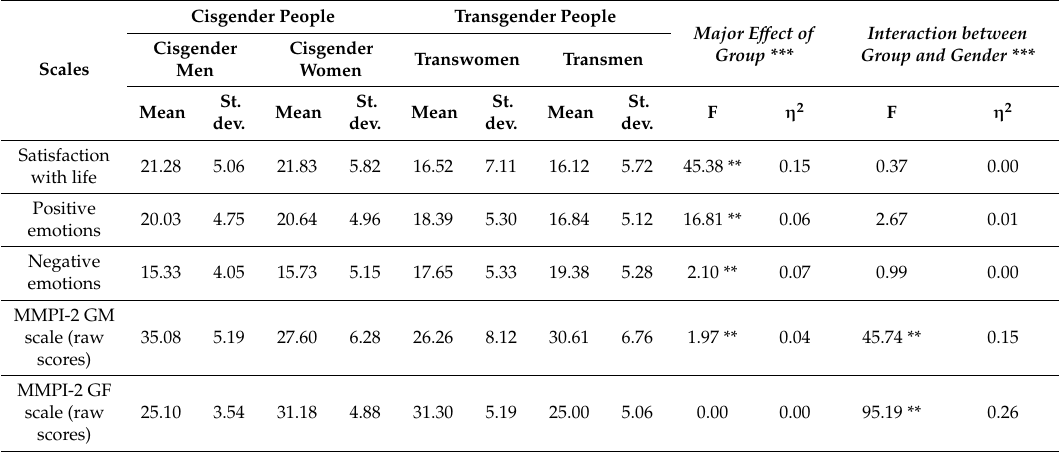
Interaction between Group and Gender *** Cisgender